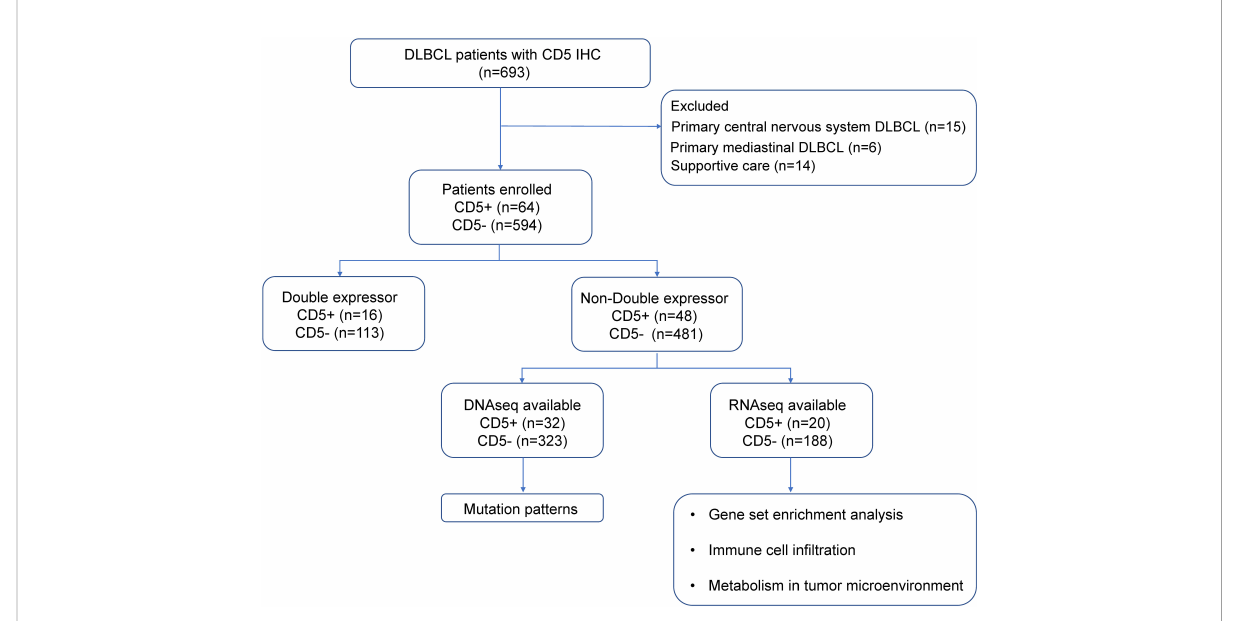
FIGURE 1 Flowchart describing the procedure of patient selection. DLBCL, diffuse large B-cell lymphoma; IHC,